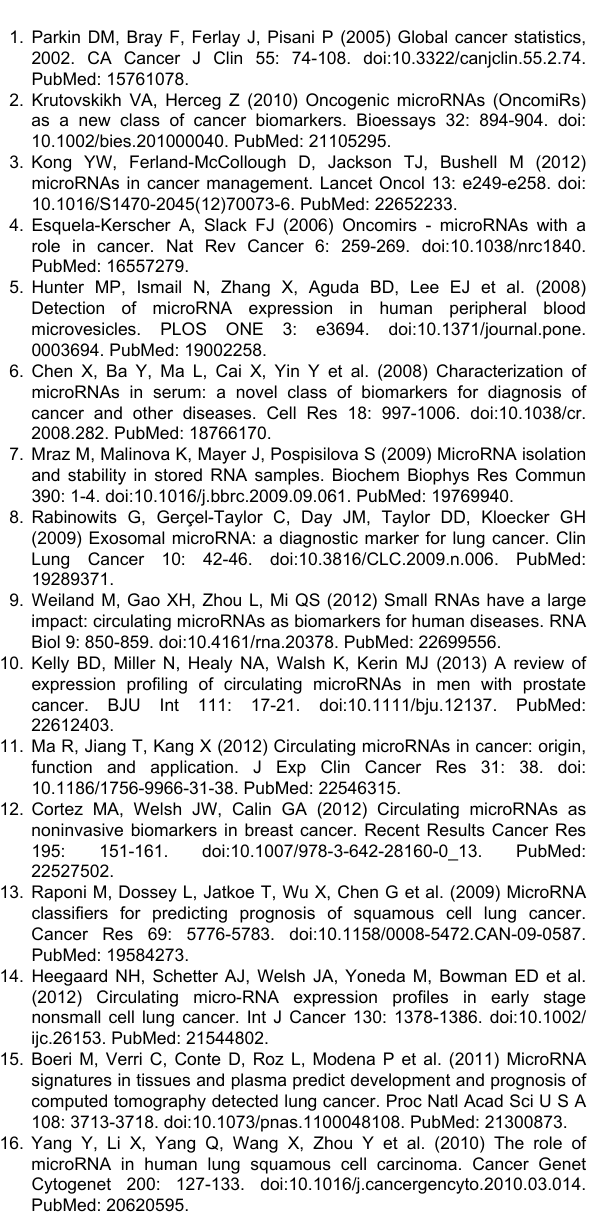
Table S1. Summary for the patients participated in the study.